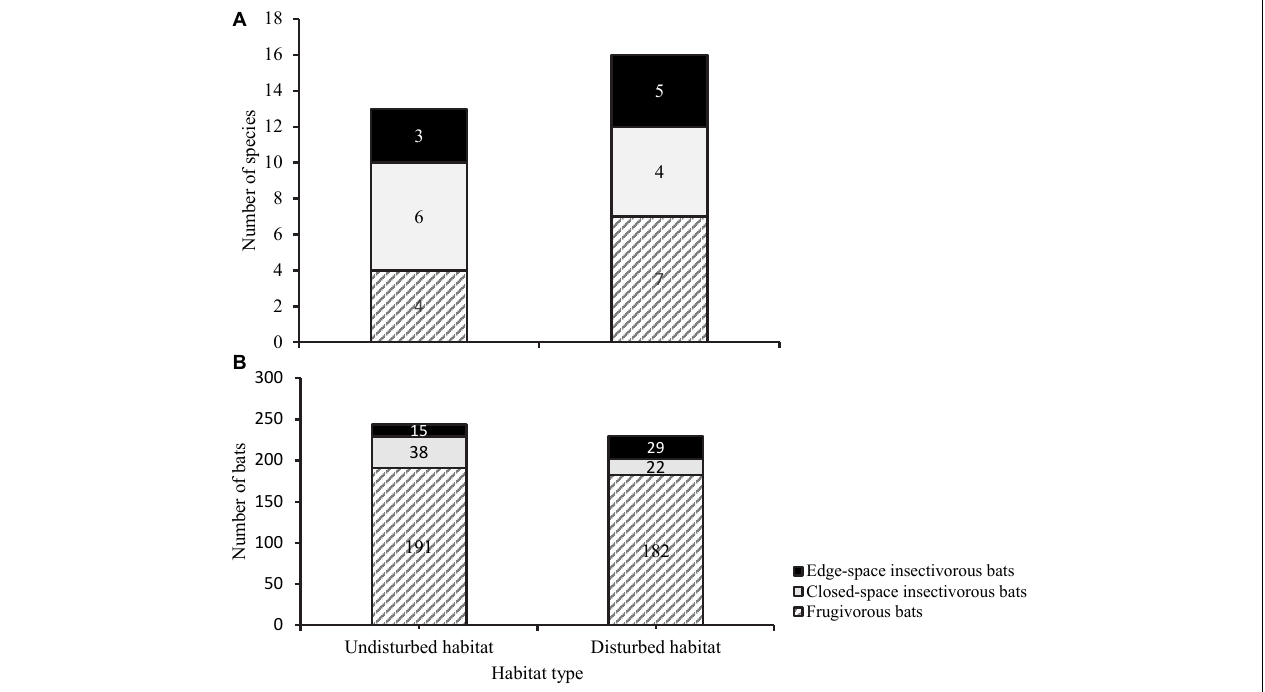
FIGURE 7 | Proportion of functional guild among bat species in undisturbed and disturbed habitat sites of the Afromontane forest biome of western Cameroon, considering species richness (A) and abundance (B) .